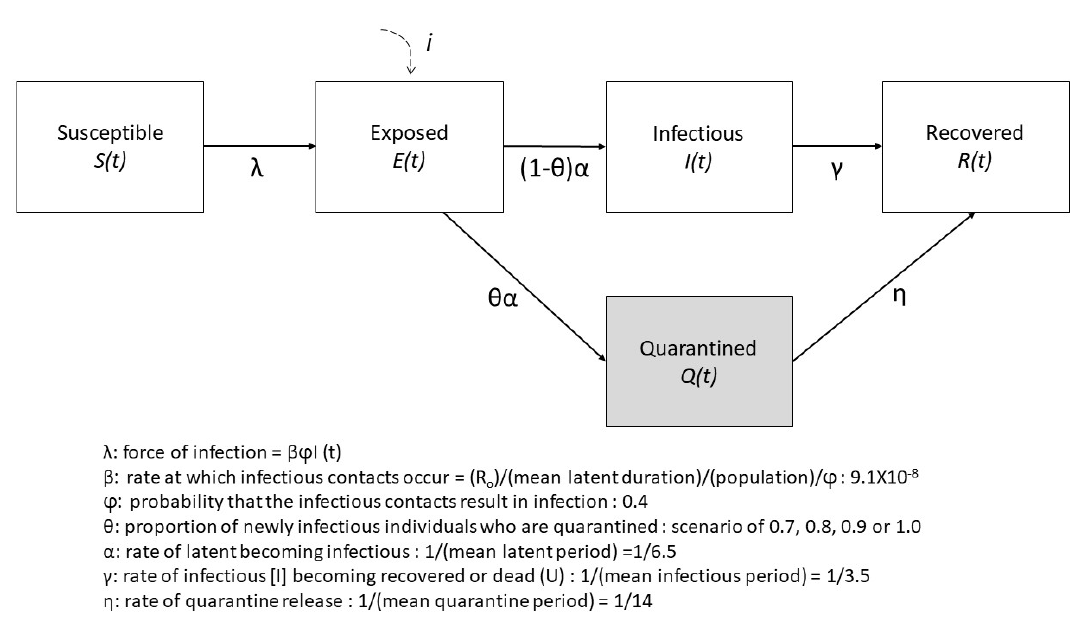
Figure 1. Graphical illustration of deterministic SEIR compartment model with quarantine. The population is divided into five classes: susceptible, exposed (infected with the virus but not infectious yet), infectious (symptomatic only), and recover. Exposed individuals are quarantined on contact tracing with a fraction of the compliance rate.